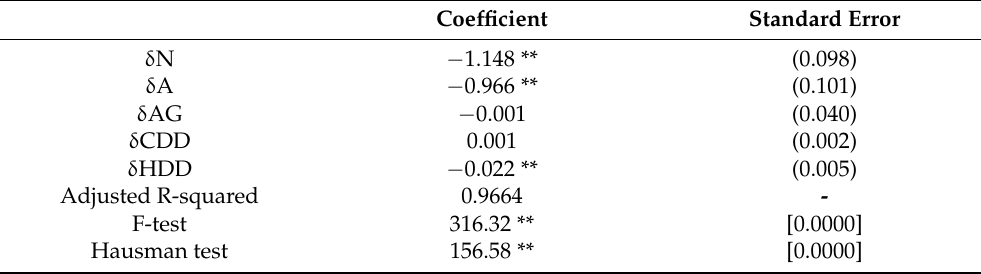
Table 7. Panel Estimation